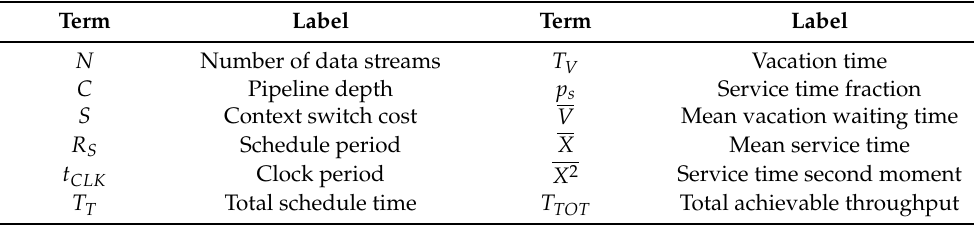
Table 1. Queueing model